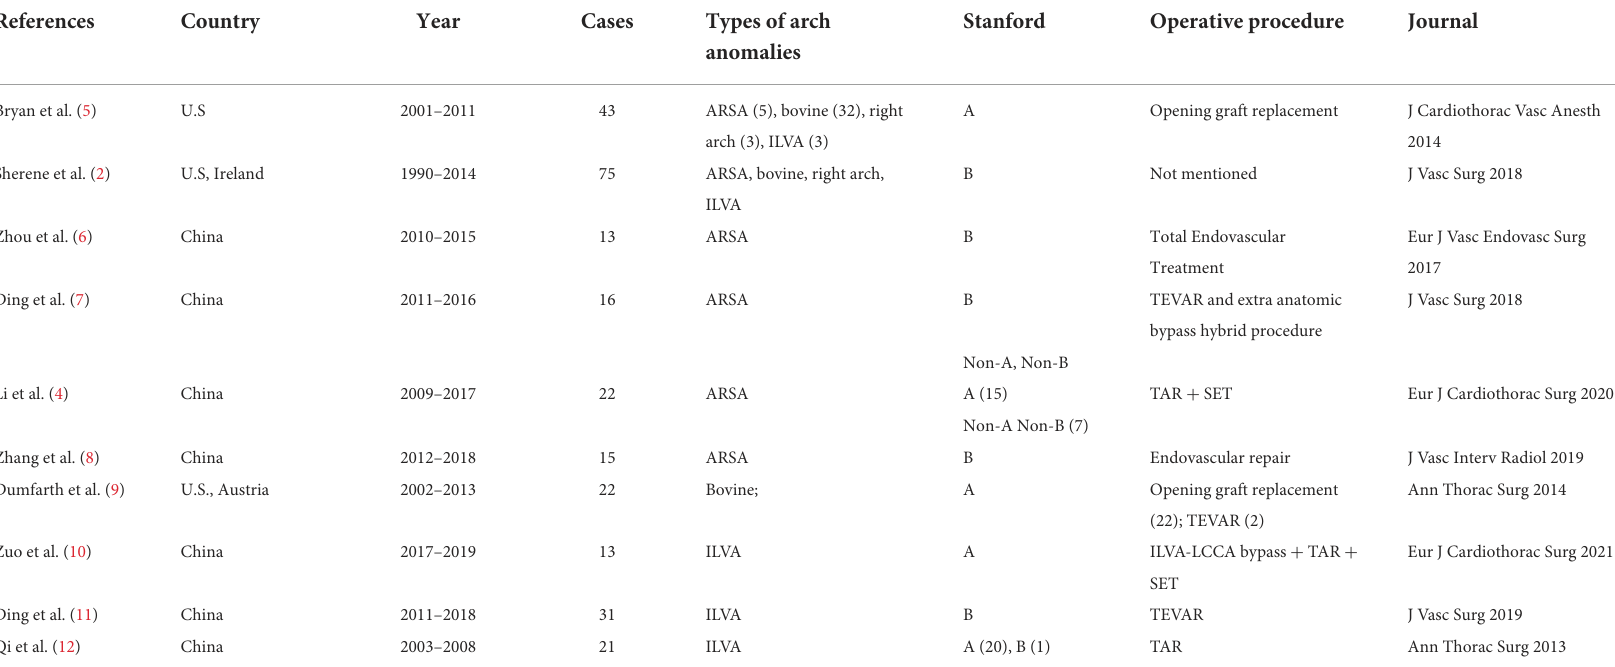
TABLE 5 Major articles of aortic dissection involving arch